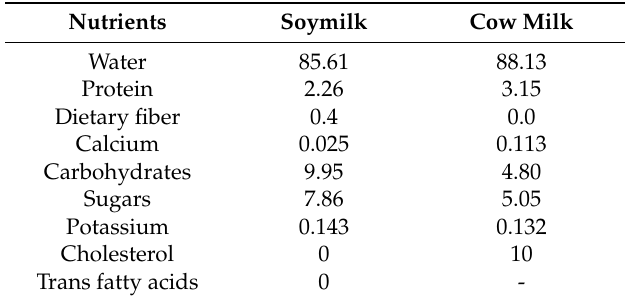
Table 1. Nutritional profile of soymilk and cow’s milk